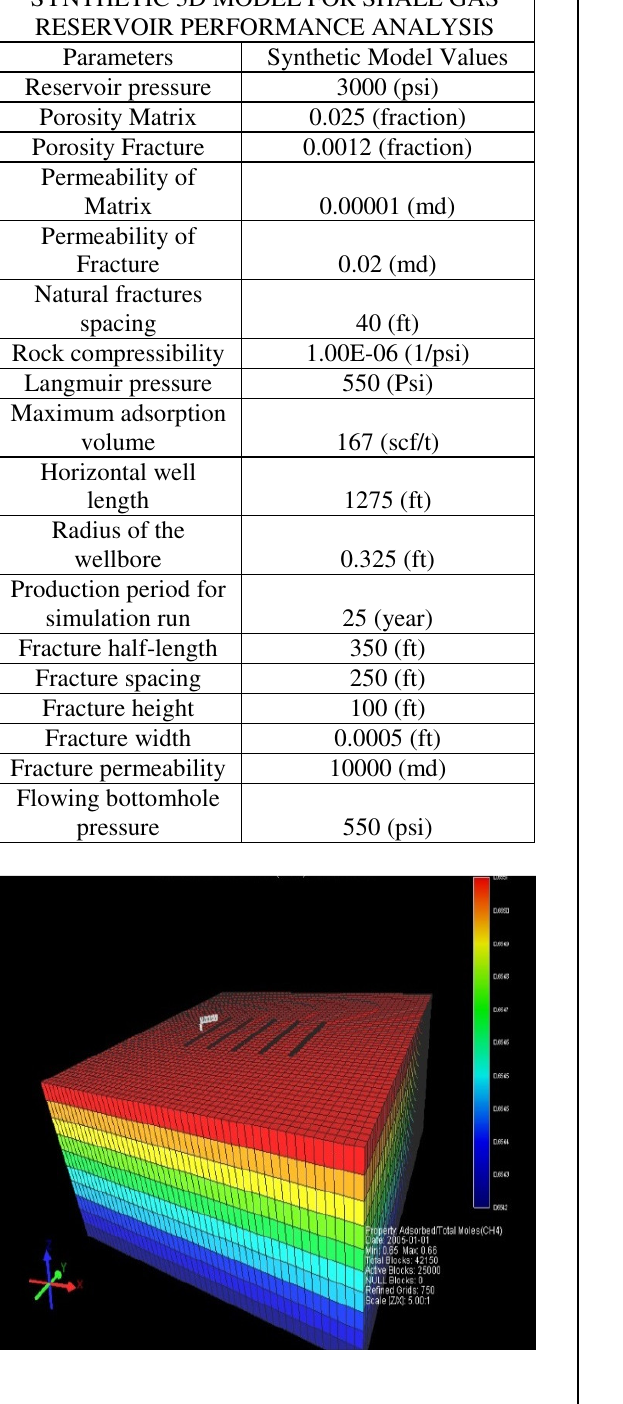
TABLE 1. PARAMETERS USED FOR